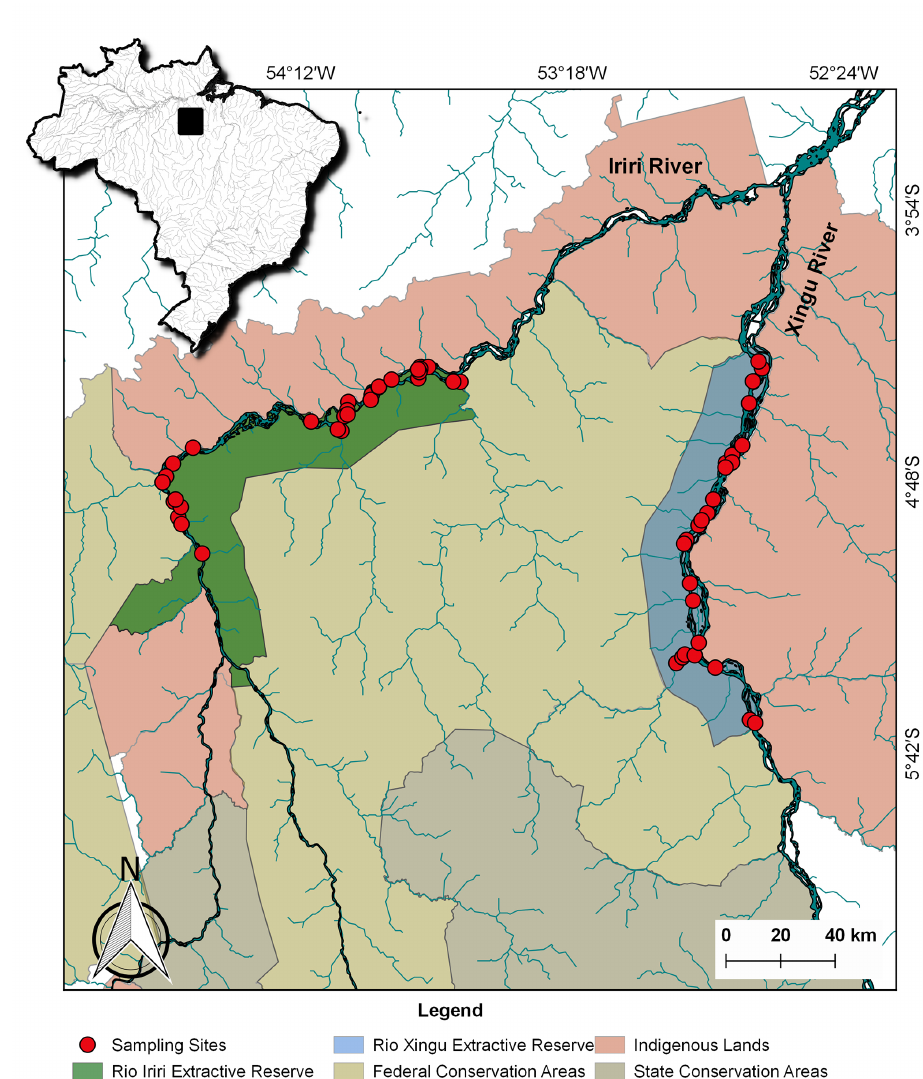
FIGURE 1 | Map of the collection areas in the Xingu and Iriri River Extractive